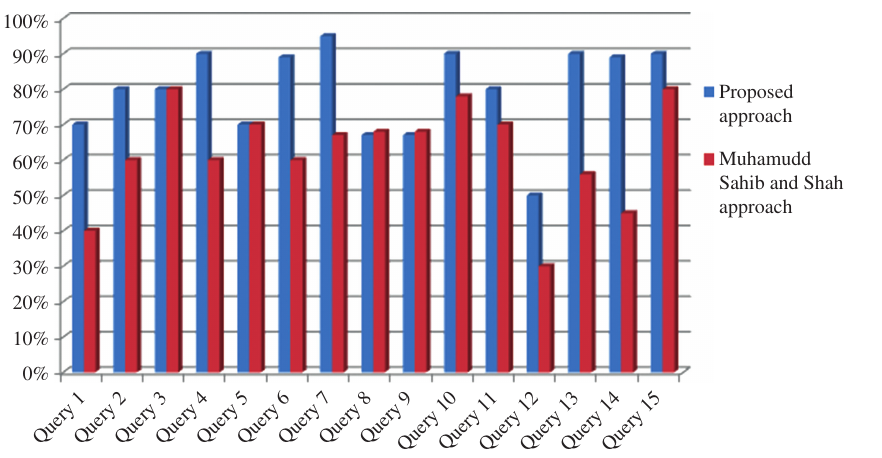
Figure 10. Performance Comparison Through the IR System.